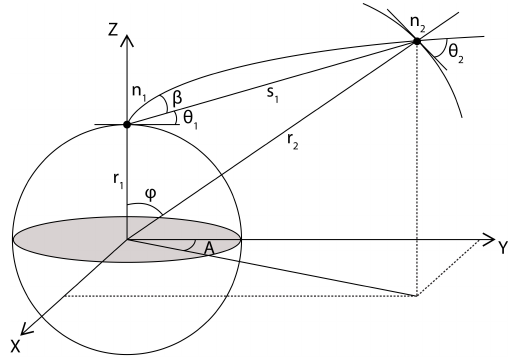
Figure A1. Illustration of ray-path model. The geometric variables are: geocentric angle φ , ray-path azimuth A , global elevation angle θ , initial bending β , radius r and geometric distance S between two consecutive ray points. Refractive index along ray-path is described by n . For details see Appendix